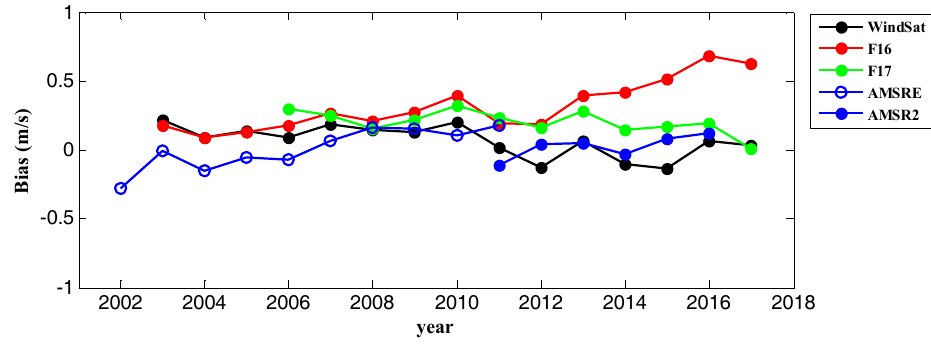
Figure 5. The mean buoy–satellite biases as a function of year for each satellite (WindSat, SSMIS F16, SSMIS F17, AMSR-E, and AMSR2).